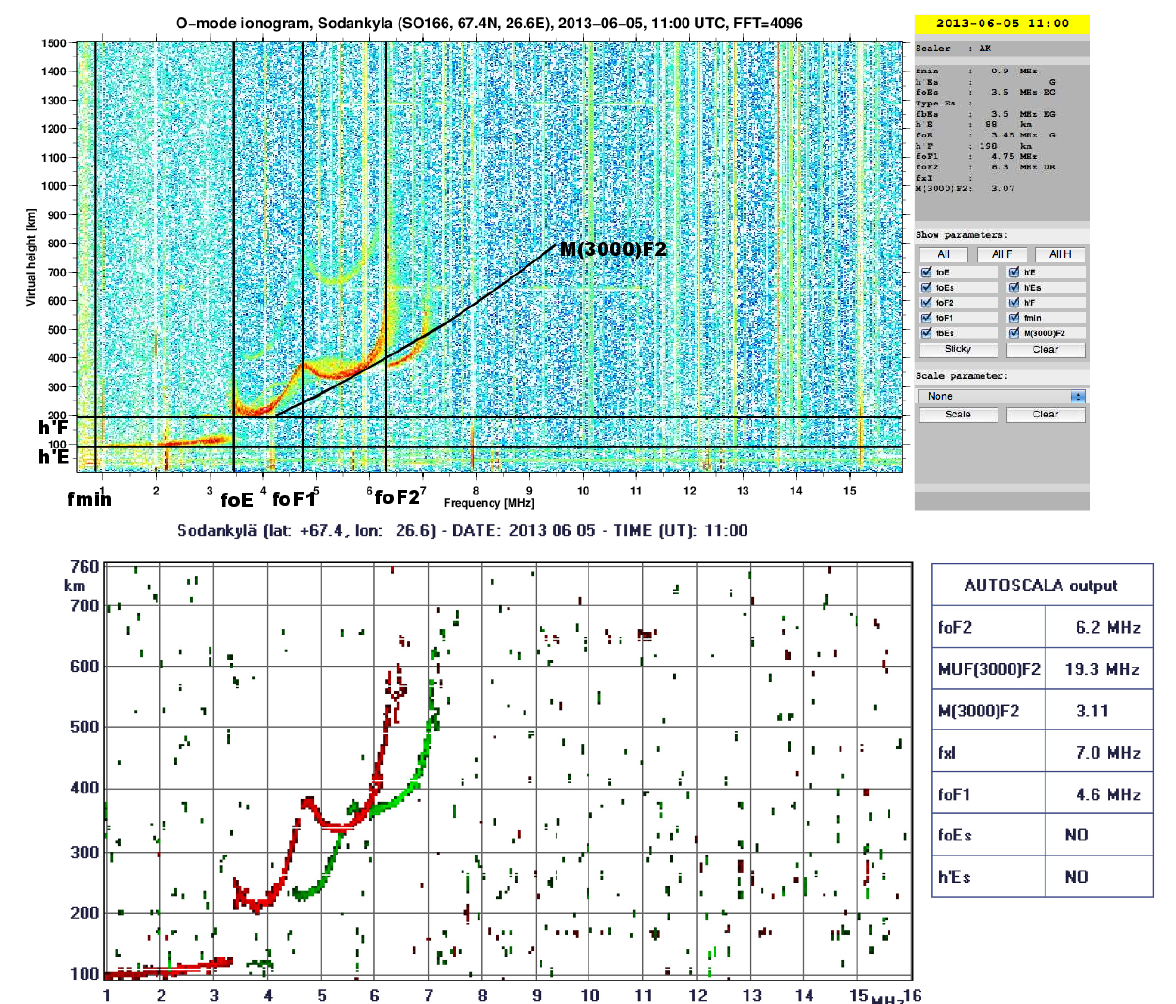
Figure 2. Example of SGO ionogram scaling. Upper: manual scaling interface with a typical Alpha Wolf O-mode ionogram (5 June 2013, 11:00UT). Colours in the ionogram represent reflected power from 20 (blue) to 110dB (red). This colour scale is not used directly by the scaler but is adjustable for best contrast. Lower: graphical output of Autoscala, input based on the same raw data but with separated, filtered O-mode (red) and X-mode (green) traces. The boxes in the right panels show the scaled parameters as described in the